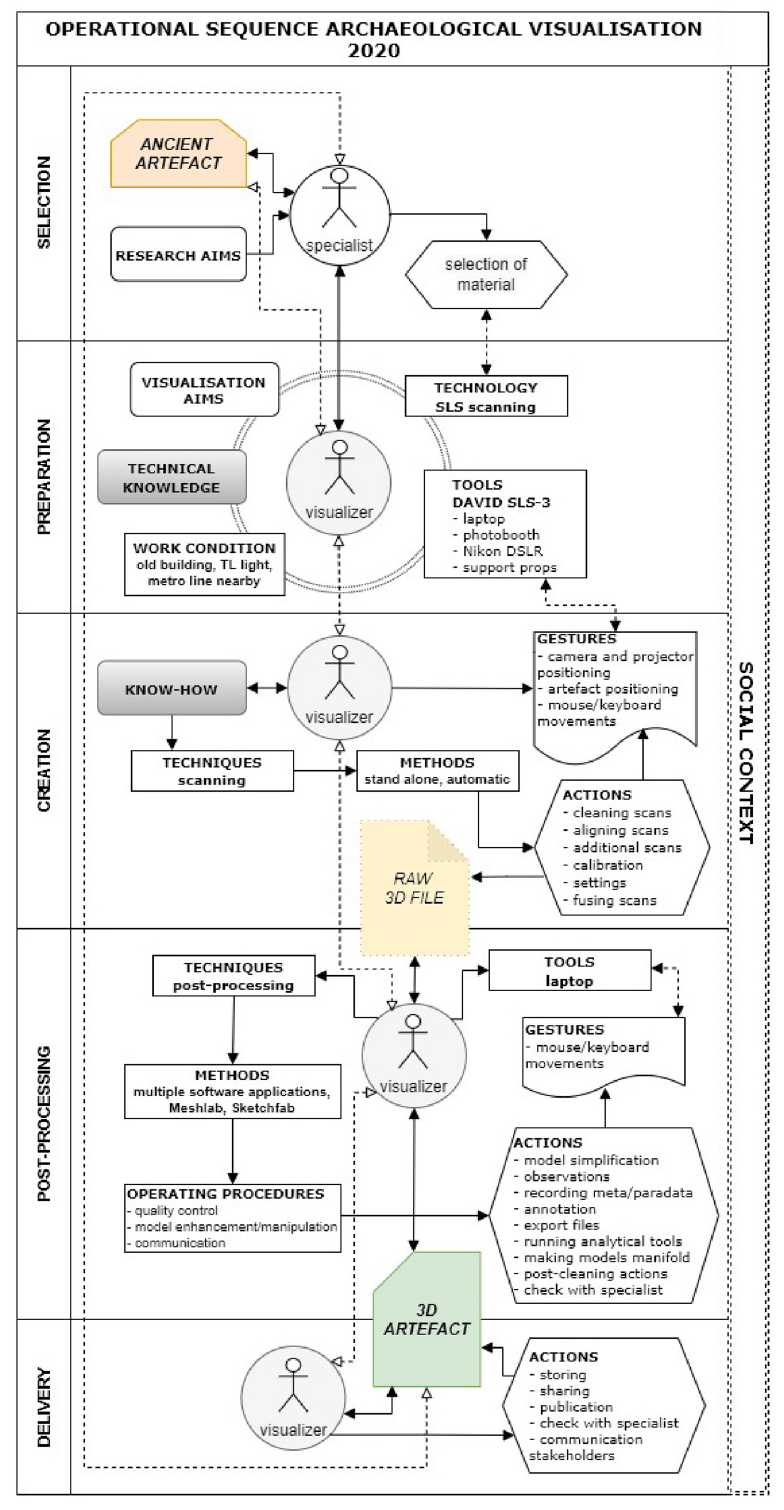
Figure 3: The operational sequence of digital archaeological visualisation in 2020. Image by the